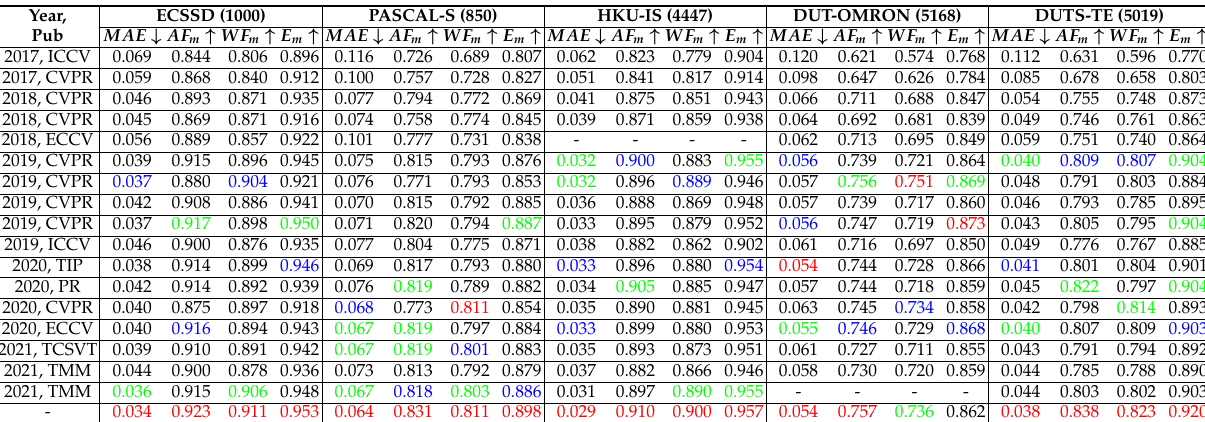
Table 1. Quantitative results on five public SOD datasets: the top three results are marked with red, green, and blue. The symbols “ ↑ / ↓ ” indicate that the larger the result, the better, and the smaller the result, the